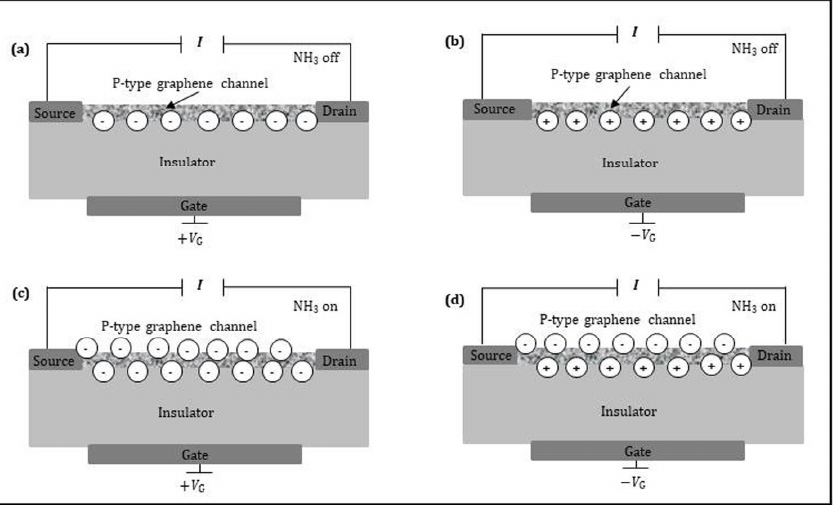
Figure 8. Schematic cross-sections of a graphene FET sensor applied by: ( a ) positive gate voltage for NH 3 off; ( b ) negative gate voltage for NH 3 off; ( c ) positive gate voltage for NH 3 on; ( d ) negative gate voltage for NH 3 on.